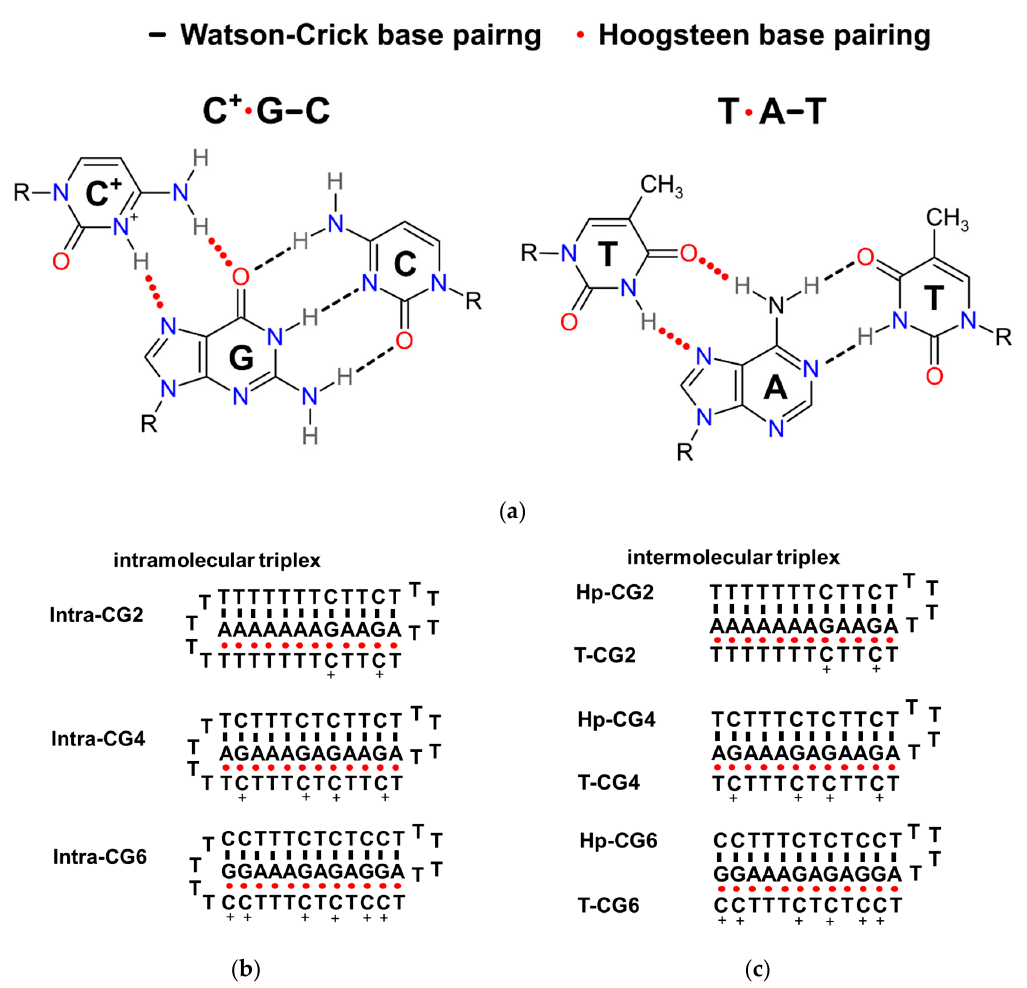
Figure 1. ( a ) The hydrogen bonding patterns of Watson – Crick base pairs and Hoogsteen base pairs in the formation of C +* G-C and T * A-T. ( b ) The possible formations of intramolecular triplexes in the sequences used in this work. ( c ) The possible formations of intermolecular triplexes in the sequences used in this work.